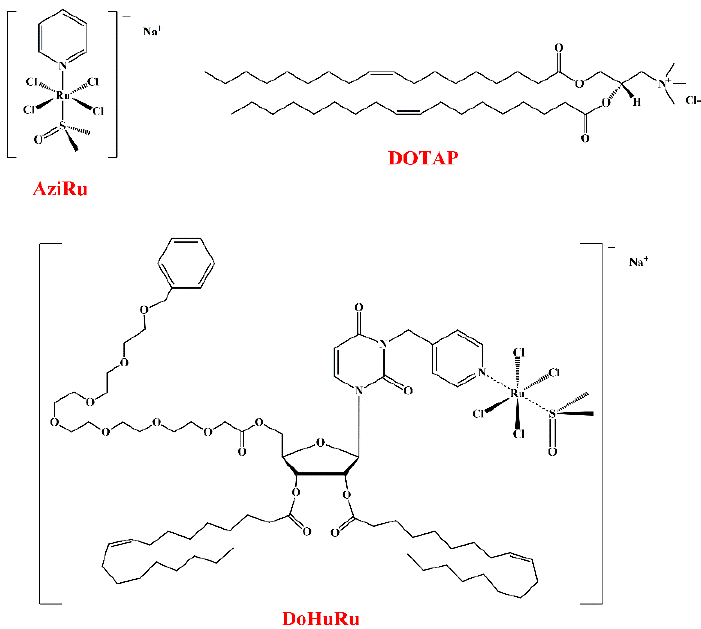
Scheme 1. Chemical structures of the Ru(III) complex AziRu, the cationic lipid DOTAP and nucleolipid-based Ru(III) complex DoHuRu, as indicated. nucleolipid-based Ru(III) complex DoHuRu, as